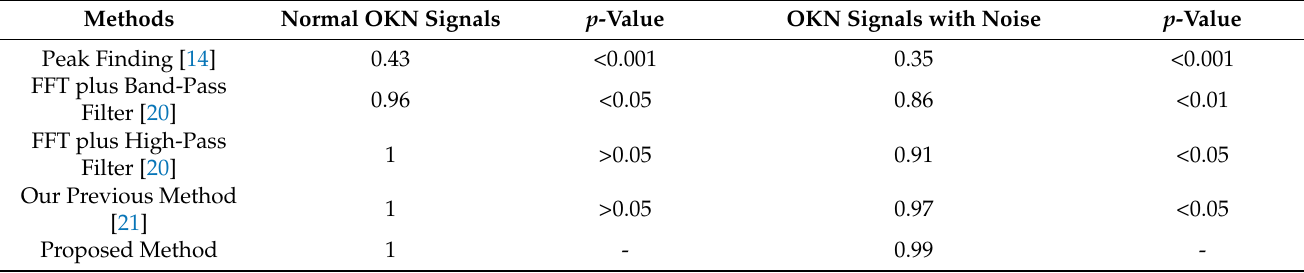
Table 1. FP recognition rate of each method in OKN and OKN with noise.